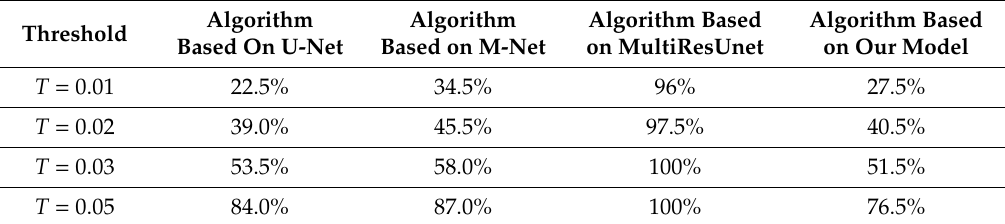
Table 7. Omission factor of sensitivity to tampering with subject unrelated changing.